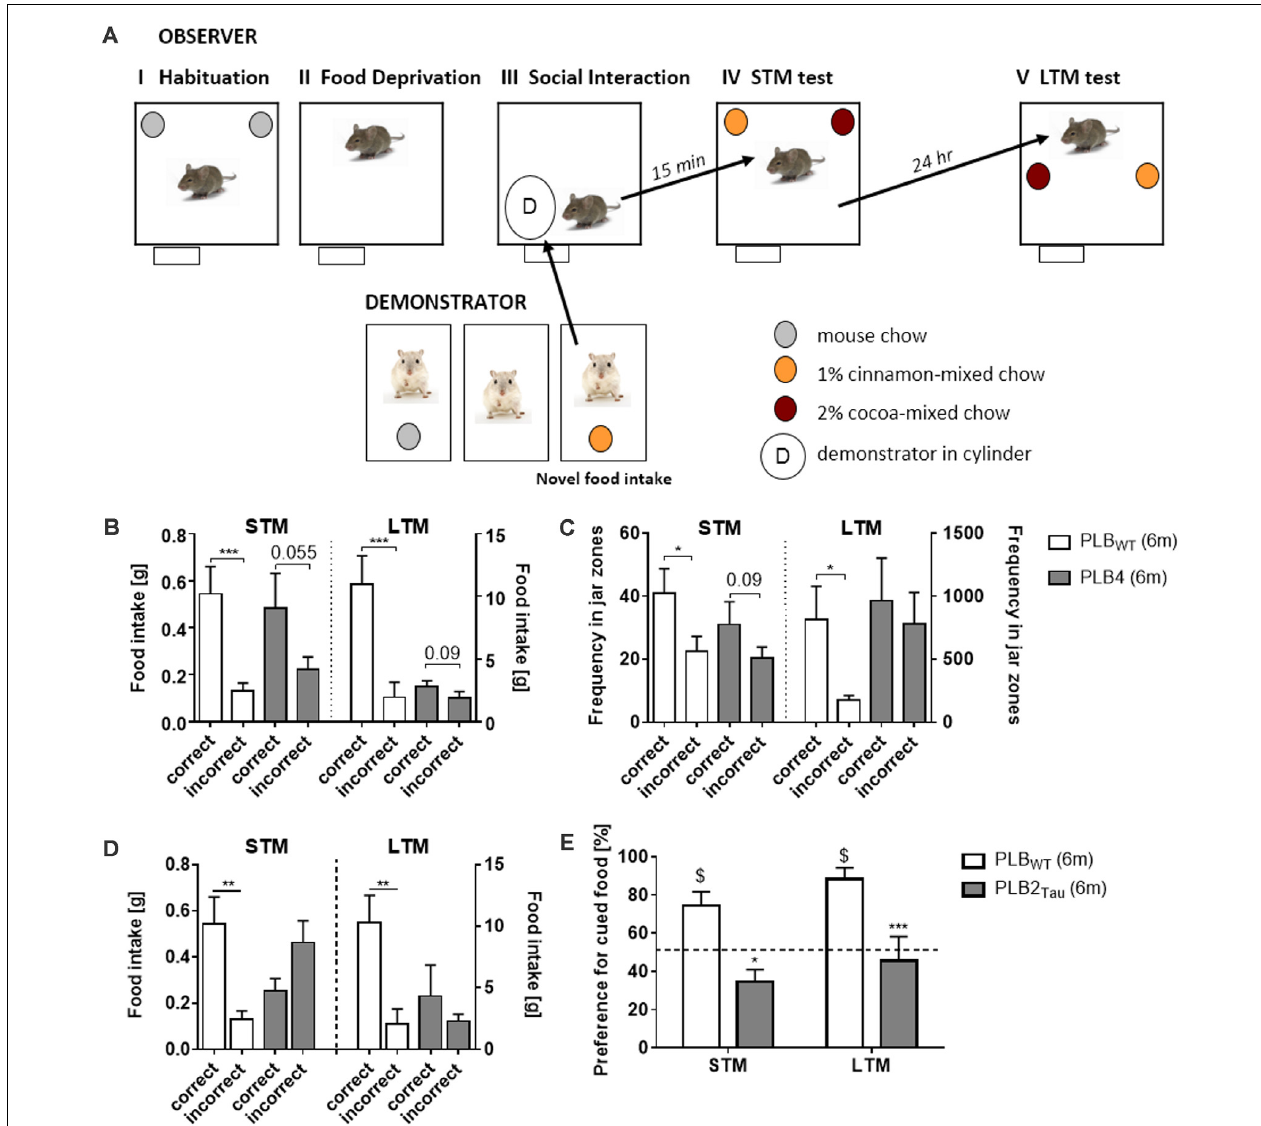
FIGURE 8 | Assessment of semantic-like memory in a home-cage environment via a social transmission of food preference (STFP) task. (A) Outline of a novel semi-automated STFP task developed in the PhenoTyper. The task consists of various phases using “observer” and “demonstrator” animals. Observer animals are initially habituated to the PhenoTyper whilst demonstrator mice are single housed, both animals are habituated to food jars containing mouse chow. Prior to the test all mice are subjected to overnight food restriction after which the demonstrator animals are given a flavored mouse chow (cocoa or cinnamon). The observer animal is subsequently exposed to the demonstrator animal via a cylinder positioned within the PhenoTyper and interaction between the two animals initiated. Social interaction for cued food was followed by either a short (15 min—STM) or long delay (24 h—LTM) prior to the mice being tested for recall via the presentation of jars containing correct and incorrect food. The amount of food consumed, and time spent in the zones associated with each jar were recorded with intact semantic memory represented by a preference for the cued food they were exposed to via the demonstrator. Analysis of correct food eaten, i.e., food matching the flavor of the demonstrator (B) , and time spent in food jar zones (C) revealed that 6 month old PLB4 mice (mice with mild overexpression of human BACE1 involved in neurodegeneration) displayed impaired memory for the cued food in both STM and LTM tests, with only PLB WT mice (i.e., mice from PLB crossings that do not carry transgenes) displaying intact memory for the cued food. Impairments in memory for the cued food were also observed with PLB2 Tau (i.e., knock-in mice which express a single copy of FTD human Tau) with mice consuming less of the correct food (D) and in contrast to age matched PLB WT mice they demonstrated no preference for the cued food in either STM or LTM tasks (E) . The figure is adapted from Pluci´nska et al. (2014) and Koss et al. (2016). * P < 0.05; ** P < 0.01; *** P < 0.001, for group comparisons. $ P < 0.05 significance vs. chance (50%).